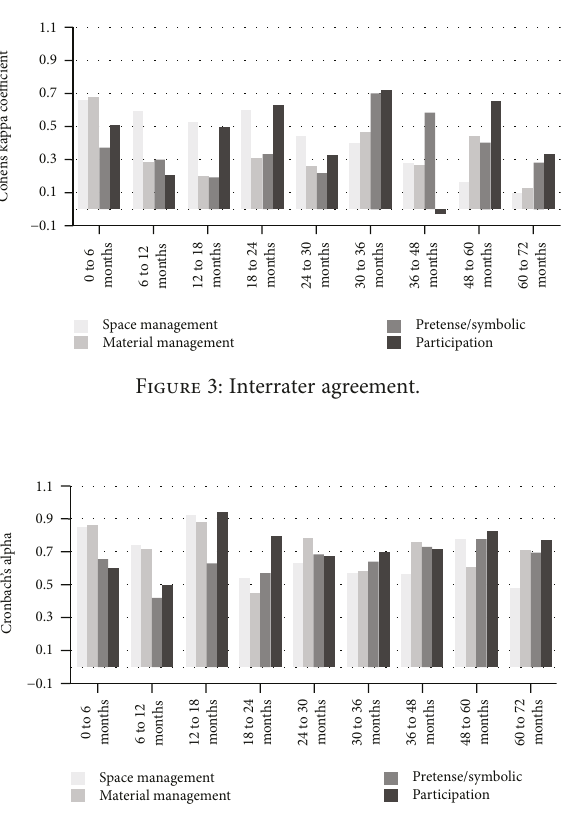
Figure 4: Internal consistency for rater 1.